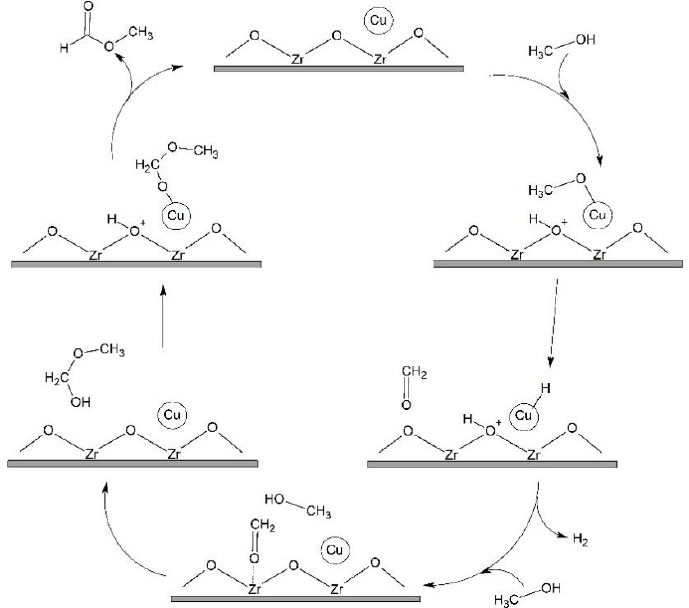
Figure 3. Proposed reaction mechanism for methanol dehydrogenation to MF [27].